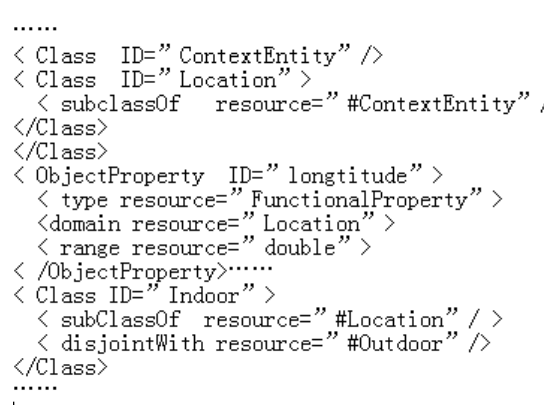
Fig. 4. Partial OWL serialization of the upper